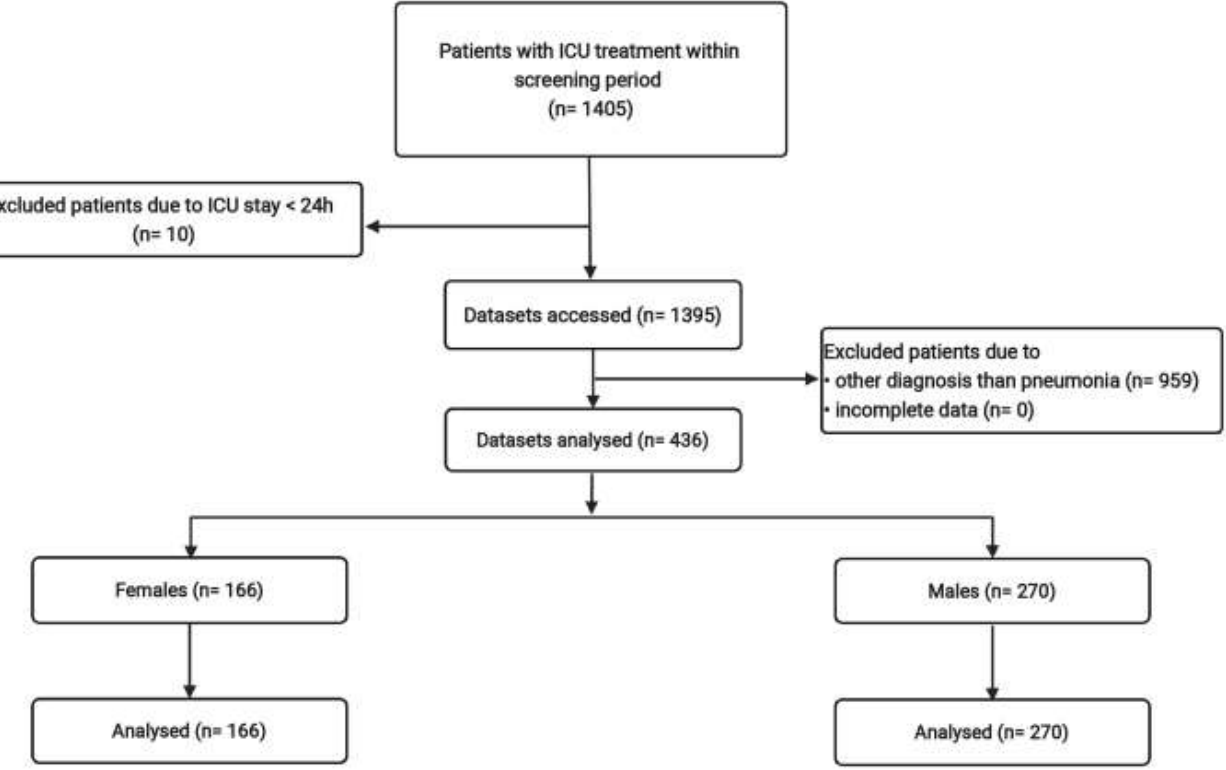
Figure 1. Figure 1. A total of 1395 surgical and non-surgical patients were included in the primary analysis of the first